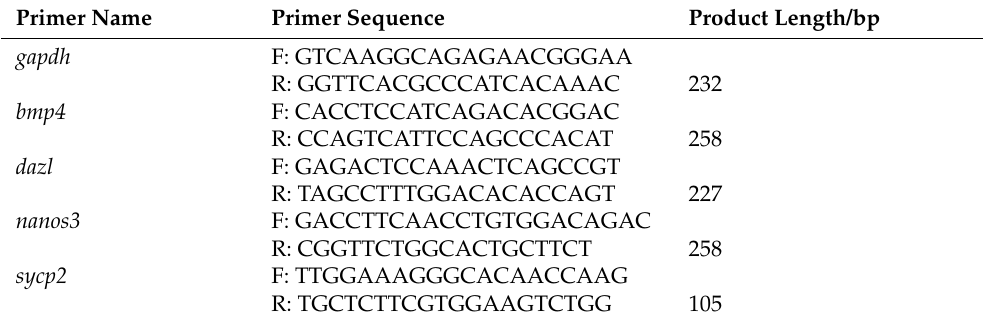
Table 1. Primer sequences of genes.